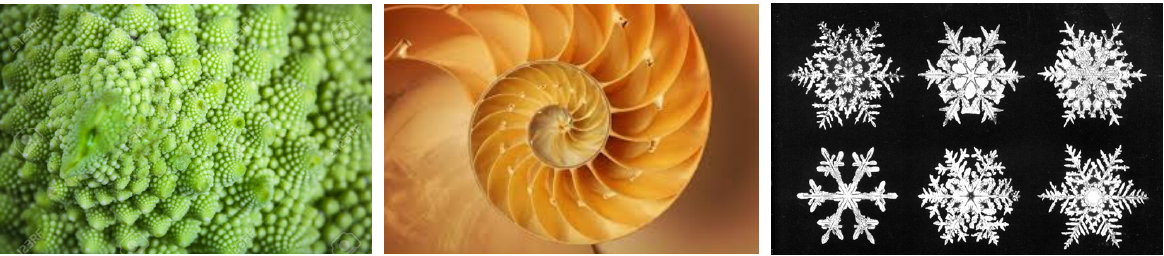
Figure 1. Fractals in nature.